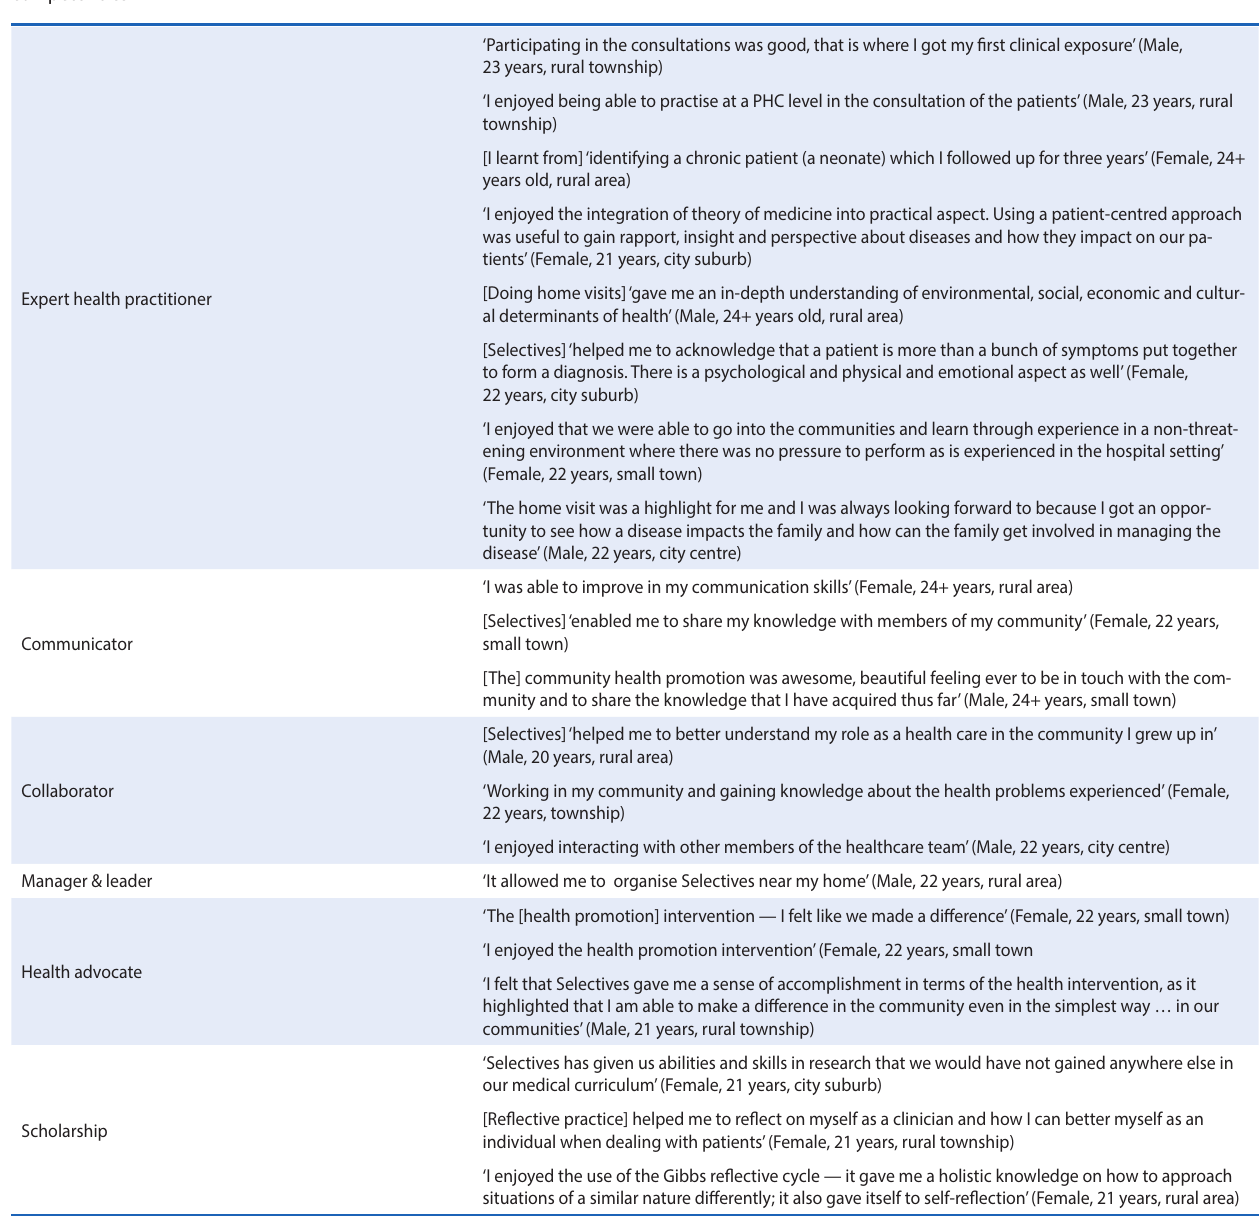
Table 2: Medical students’ (sex, age and Selectives site) comments about their experiences in the Selectives categorised according to the HPCSA core competencies